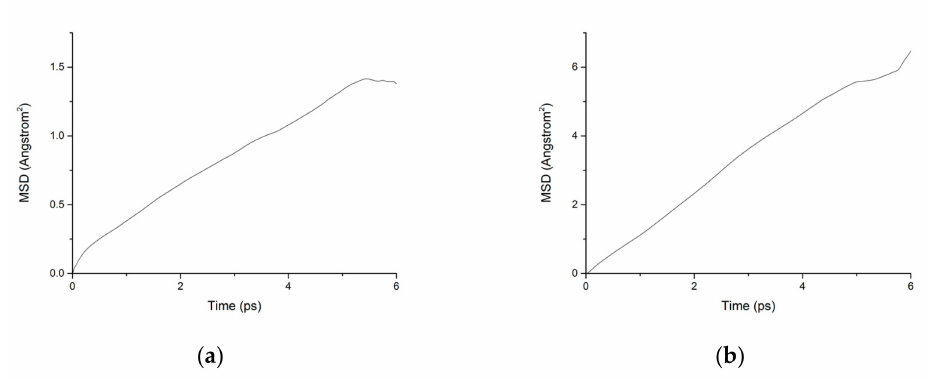
Figure 10. MSD diagram of water molecules in C-S-H nanopores without fatigue loading. ( a ) Pore diameter: 1.5 nm. ( b ) Pore diameter: 3 nm.